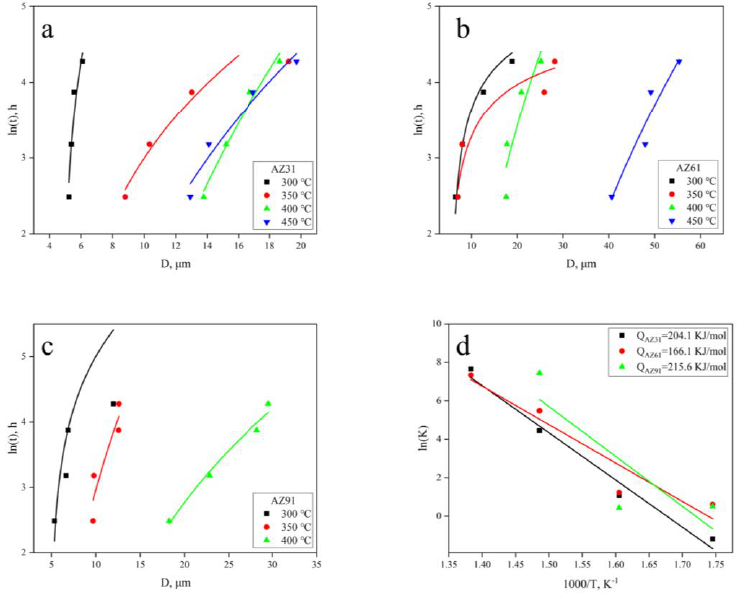
Figure 9. Plots of ln( t ) against the average grain size D: ( a ) AZ31, ( b ) AZ61, ( c ) AZ91; ( d ): plot of ln( K ) against 1000/ T. Table 2. The values of the fitted parameters n , and K for Mg – xAl – 1Zn (x = 3, 6, 9) alloys at different annealing conditions.